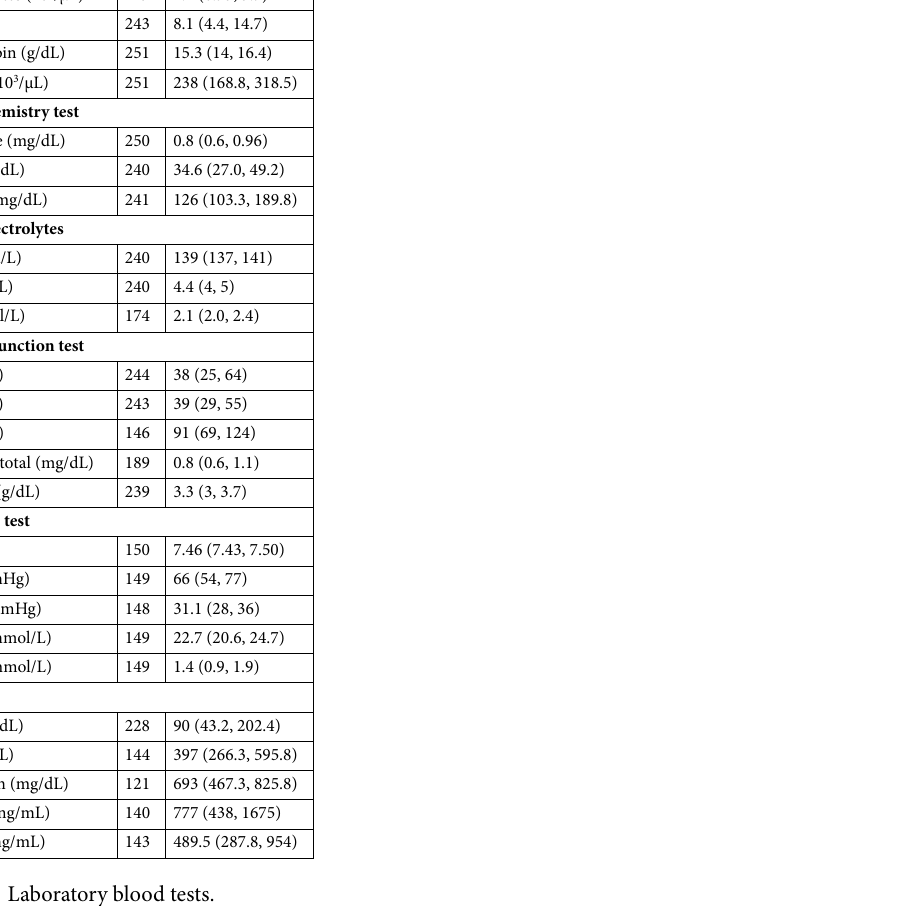
Table 4. Laboratory blood